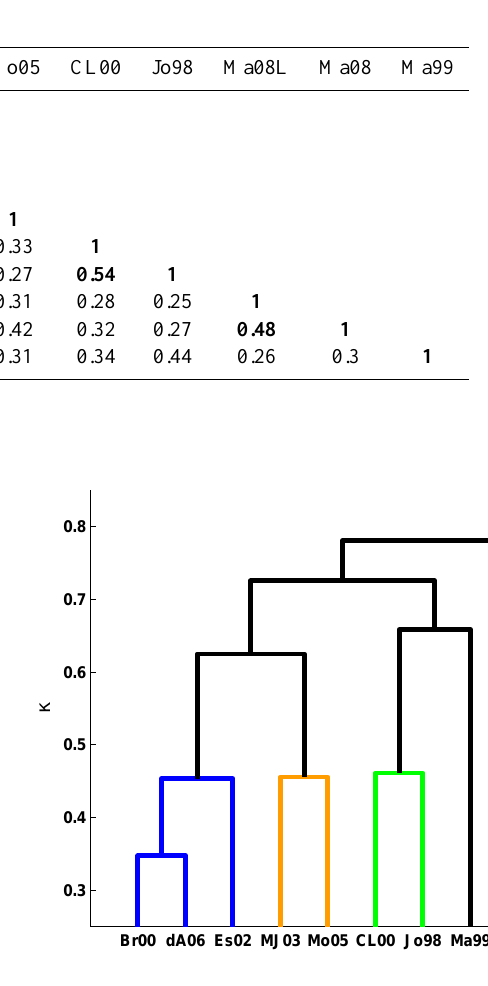
Fig. 1. Dendrogram of reconstructions, with distance metric D based on coherence κ (see text). Each node immediately below the 99% significance level of D =0.525 corresponds to a significant cluster, signified by the coloring.